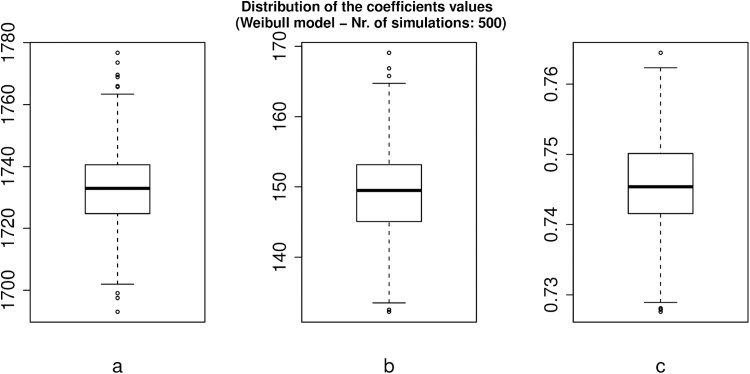
Boxplots of the distribution of the Weibull fit parameters a, b, and c in 500 simulations.